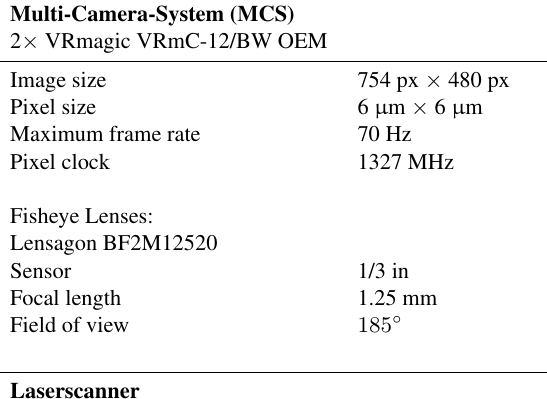
Multi-Camera-System (MCS)